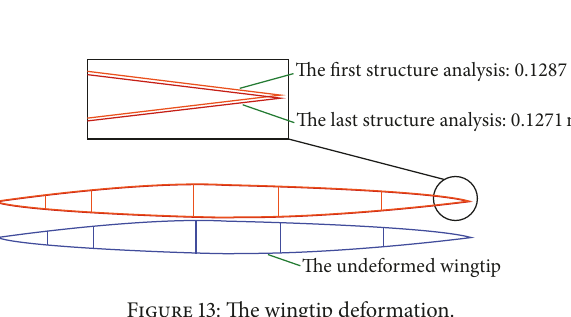
Figure 13: The wingtip deformation.